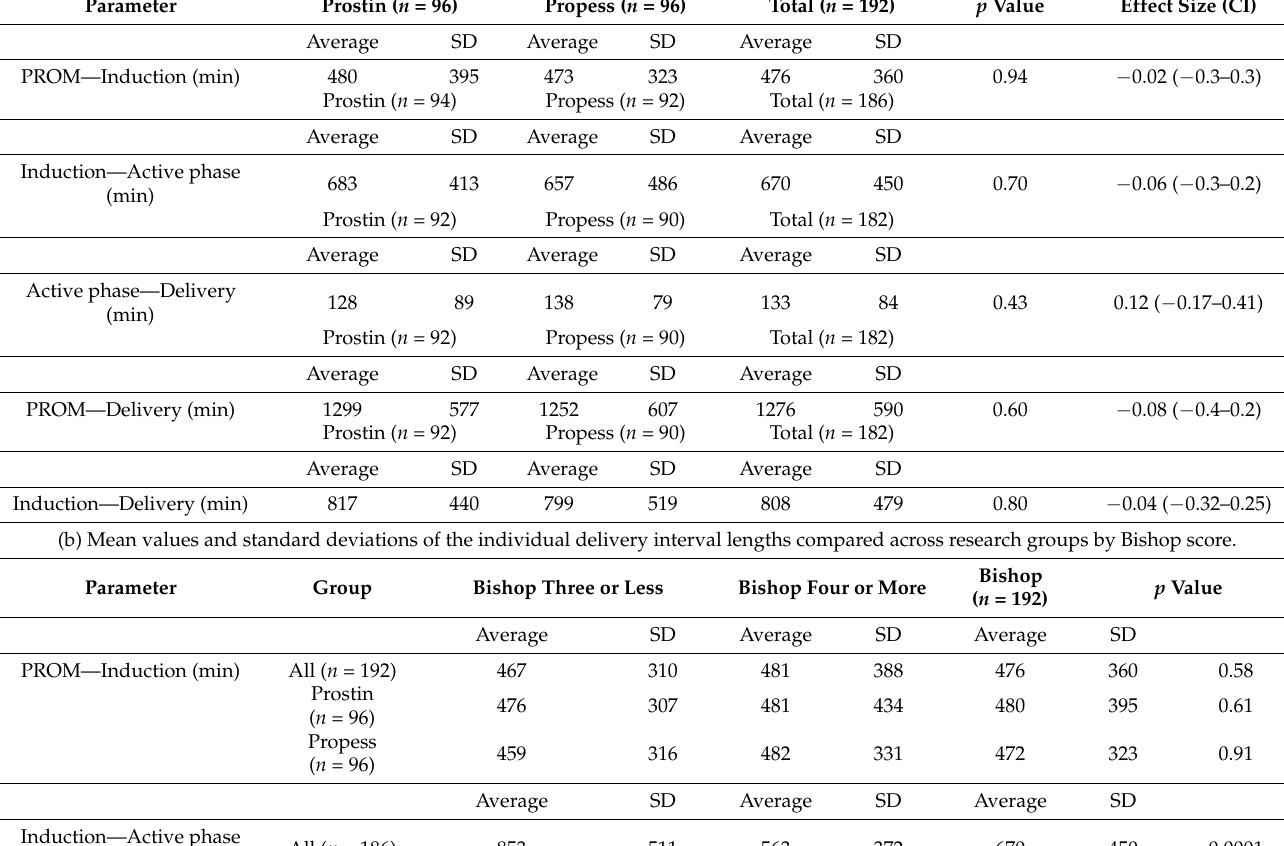
Table 6. Individual delivery interval lengths across different criteria. SD—standard deviation, CI confidence